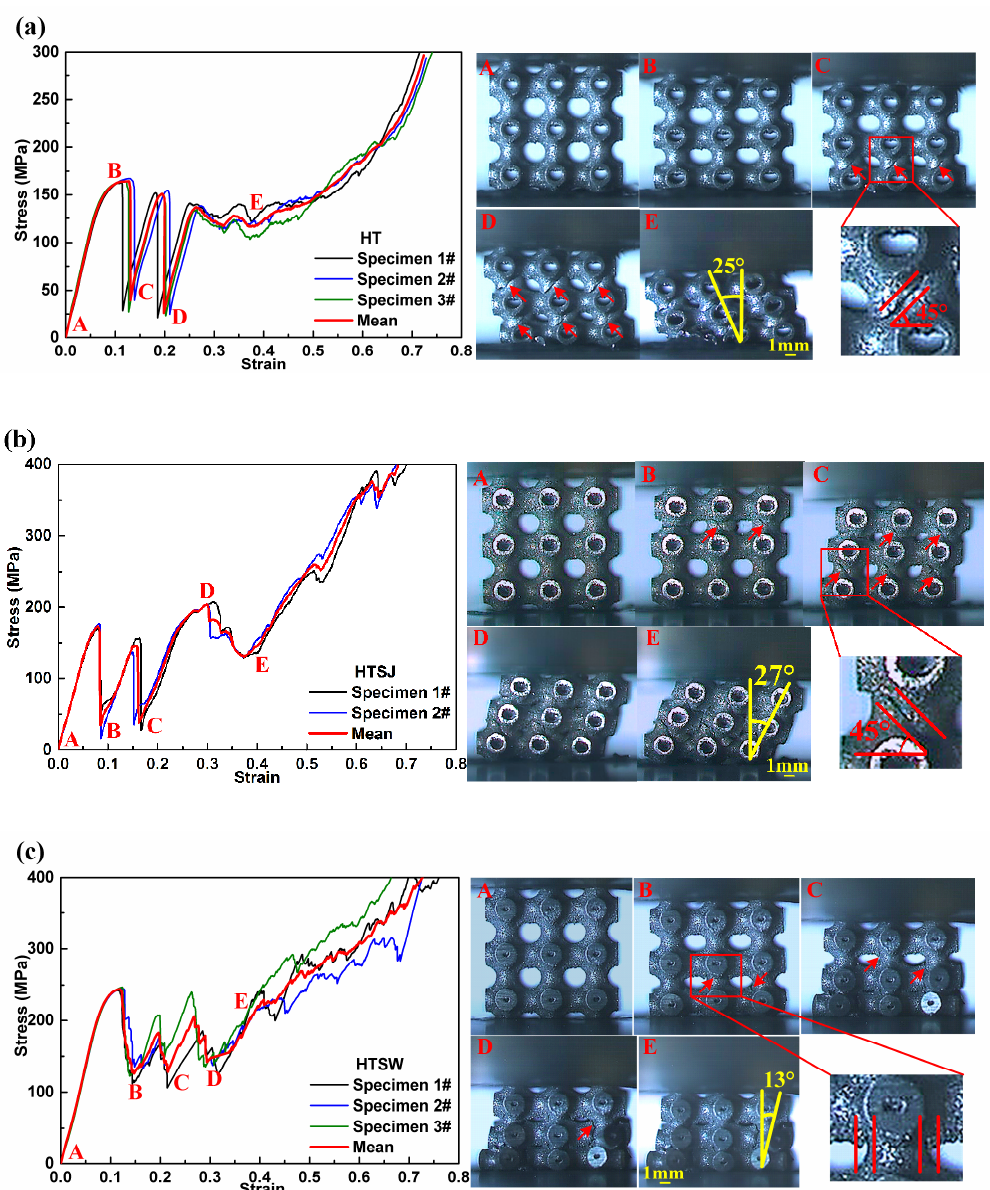
Figure 3. The stress–strain curves and deformation characteristics of the different specimens ( a ) specimen HT, ( b ) specimen HTSJ and ( c ) specimen